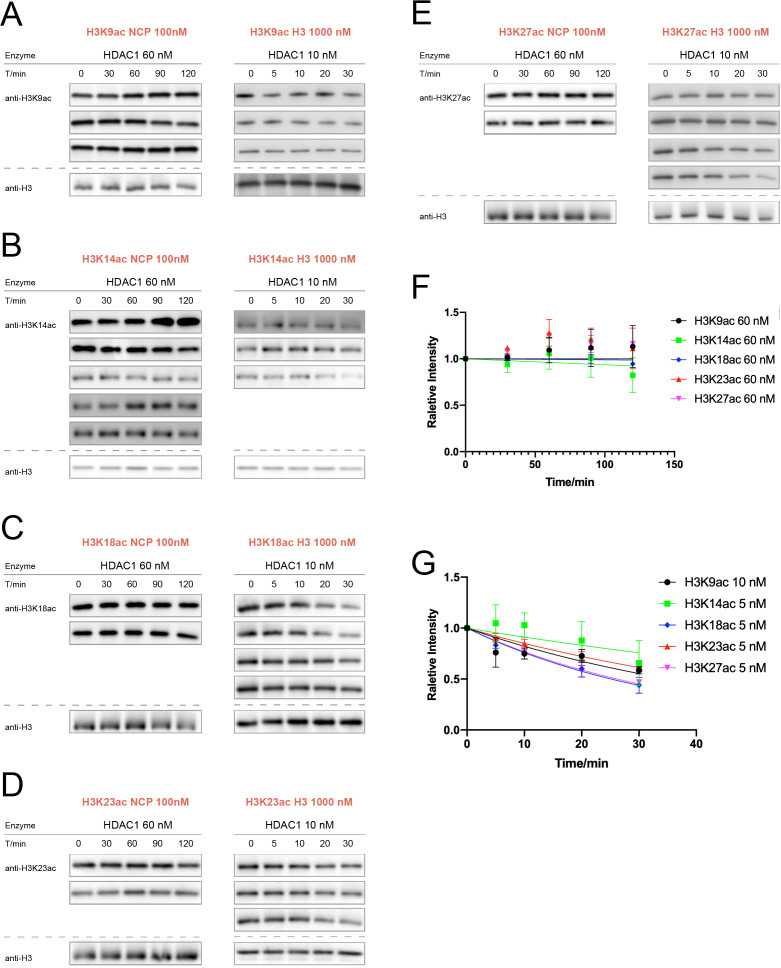
HDAC1 activity assay over nucleosomes or histones with acetylation at different sites.(A) H3K9ac (n = 3 for nucleosome assay; n = 3 for histone assay), (B) H3K14ac (n = 5 for nucleosome assay; n = 3 for histone assay), (C) H3K18ac (n = 2 for nucleosome assay; n = 4 for histone assay), (D) H3K23ac (n = 2 for nucleosome assay; n = 3 for histone assay), (E) H3K27ac (n = 2 for nucleosome assay; n = 4 for histone assay). (F) Curve fitting for nucleosome kinetics with 60 nM HDAC1 labeled in the graph; and (G) Curve fitting for histone kinetics with 5 or 10 nM HDAC1 labeled in the graph.